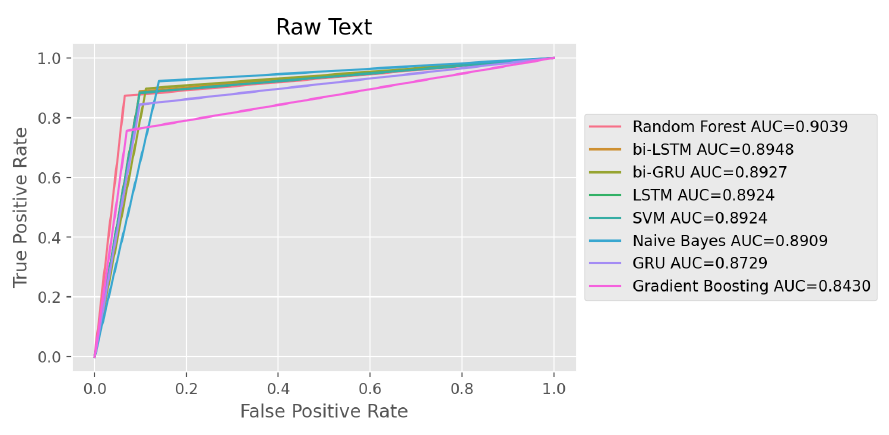
Figure 9. ROC curve and AUC of proposed models when using raw